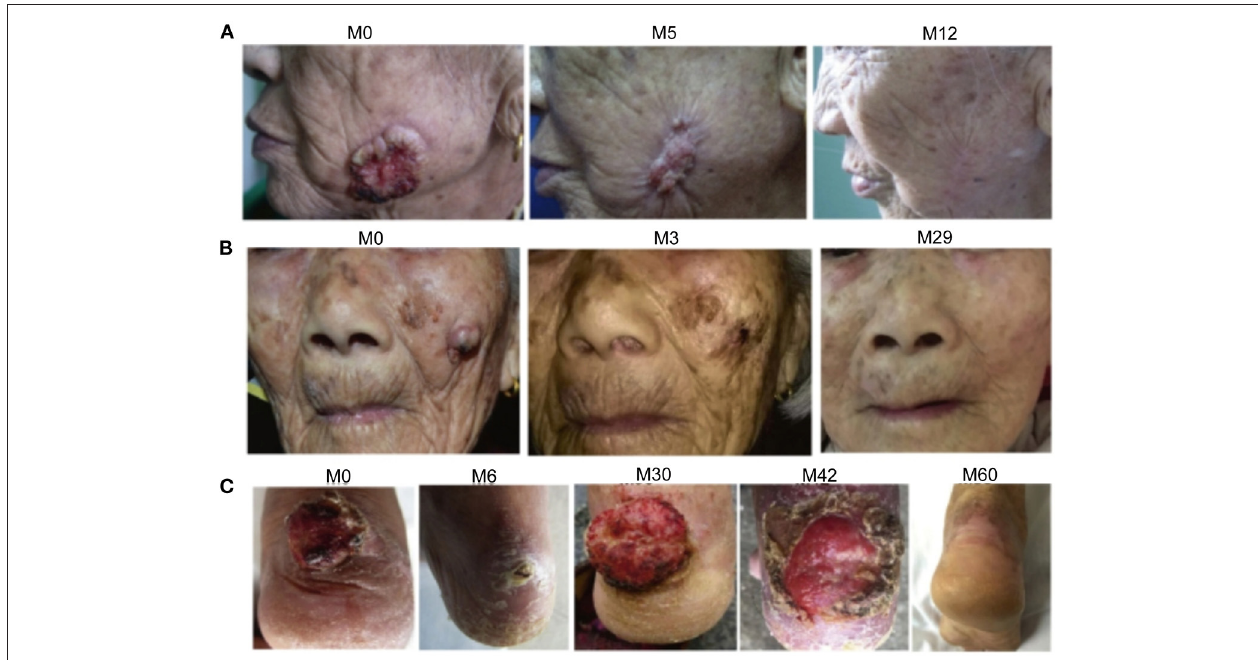
FIGURE 1 | Photographs showing the regression of cutaneous squamous cell carcinoma (CSCC) in three patients treated with acitretin and clarithromycin. (A) Patient 1. The CSCC on the left cheek is shown at month 0 (before initiation of combination therapy), 5 and 12. (B) Patient 2. The CSCC on the left cheek is shown at month 0, 3, and 29. (C) Patient 3. The CSCC on the right ankle is shown at month 0, 6, 30, 42, and